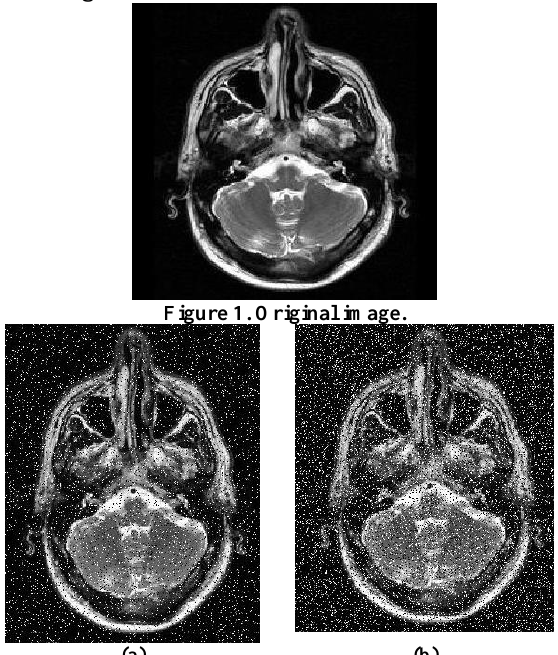
Figure 1. Original image.